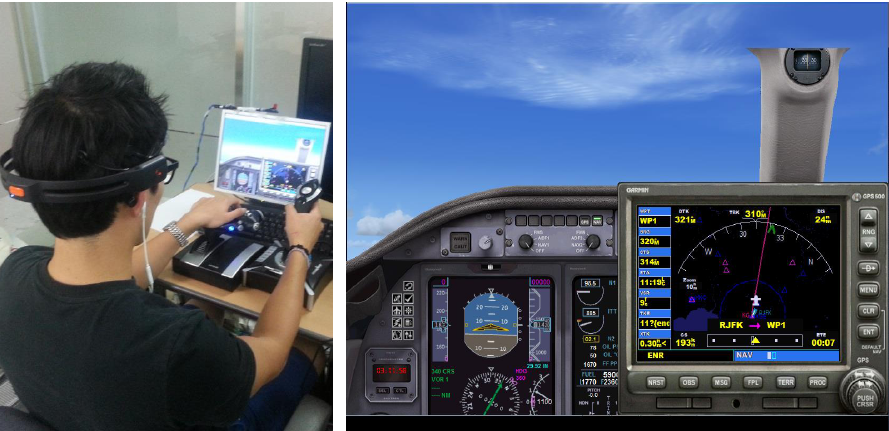
Figure 11. Snapshots of experimental environment including equipment ( left ) and flight simulator ( right